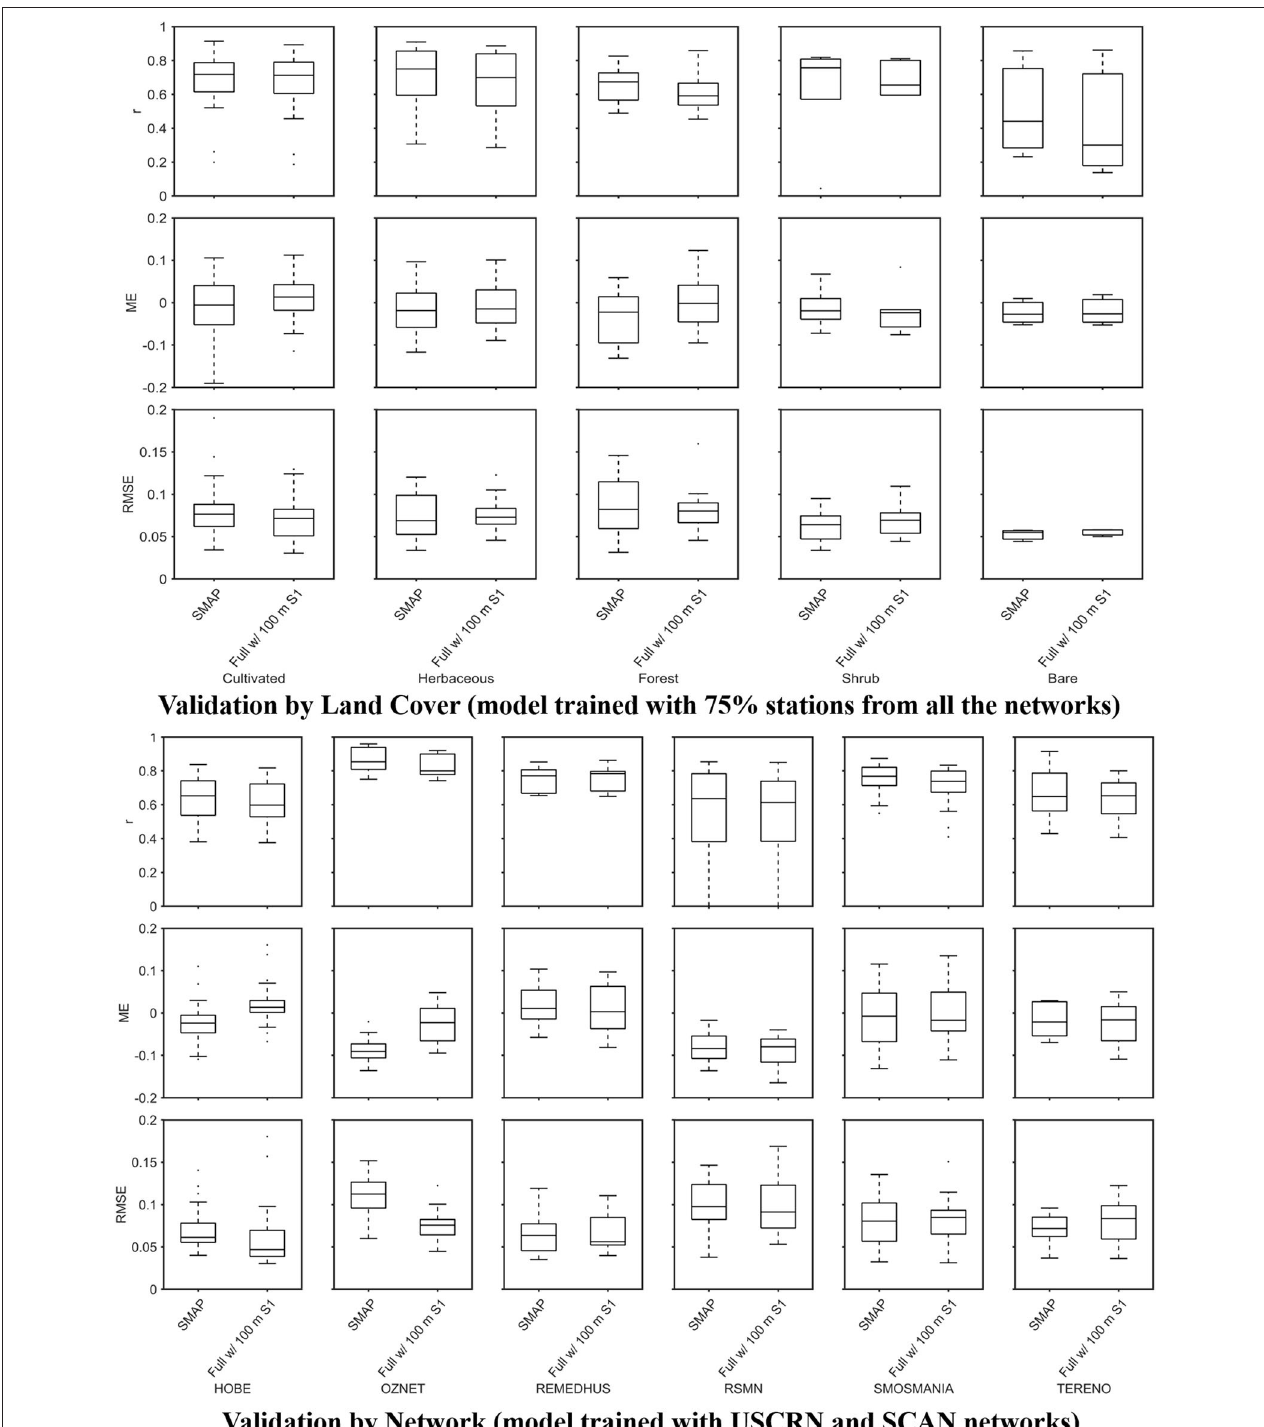
FIGURE 4 | Boxplots of the performance of SMAP L3 product (SMAP) and quantile random forest (QRF) models on individual regional- and continental- scale validation station evaluated by land cover (trained and validated using 70 and 30% of stations from all networks) and by network (trained using continental networks—USCRN and SCAN and validated using other regional networks). The QRF models were established using all input covariates with Sentinel-1 data aggregated at 100m (Full w/100m S1). R2, coefficient of determination; ME, mean error; RMSE, root mean squared error.